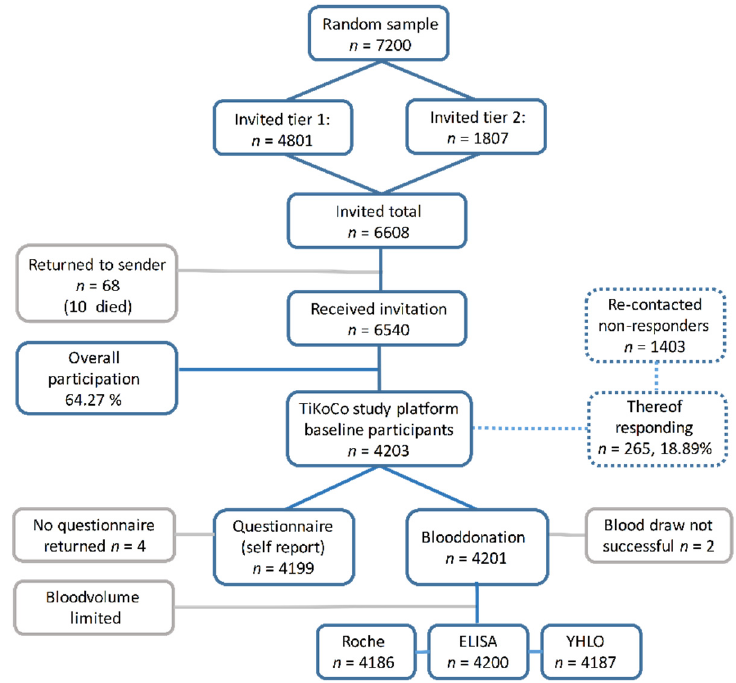
Figure 1. Summary of the TiCoKo study design. The strategy and numbers ( n ) underlying the random sampling and recruitment of study participants, the collection of information via a self-reporting questionnaire as well as the testing strategy to determine the true serostatus of the participants via three independent test formats (Roche-Cobas, in-house ELISA and YHLO) are shown. Measures to minimize and understand non-response are indicated (dashed line), reasons for drop-outs of participants, numbers of returned questionnaires, and successful blood samples are given (grey line). Figure was designed using PowerPoint 365 for Windows, Microsoft, Redmond Washington, DC, USA, www.microsoft.com.